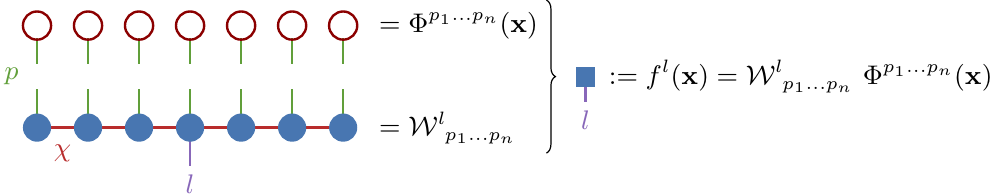
Figure 3 . Feature tensor contraction with an MPS. Red nodes represents each mapped feature, blue nodes represent individual tensors of an MPS, the green, red and purple line represents physical dimensions, p i , auxiliary dimensions, χ and output label, l